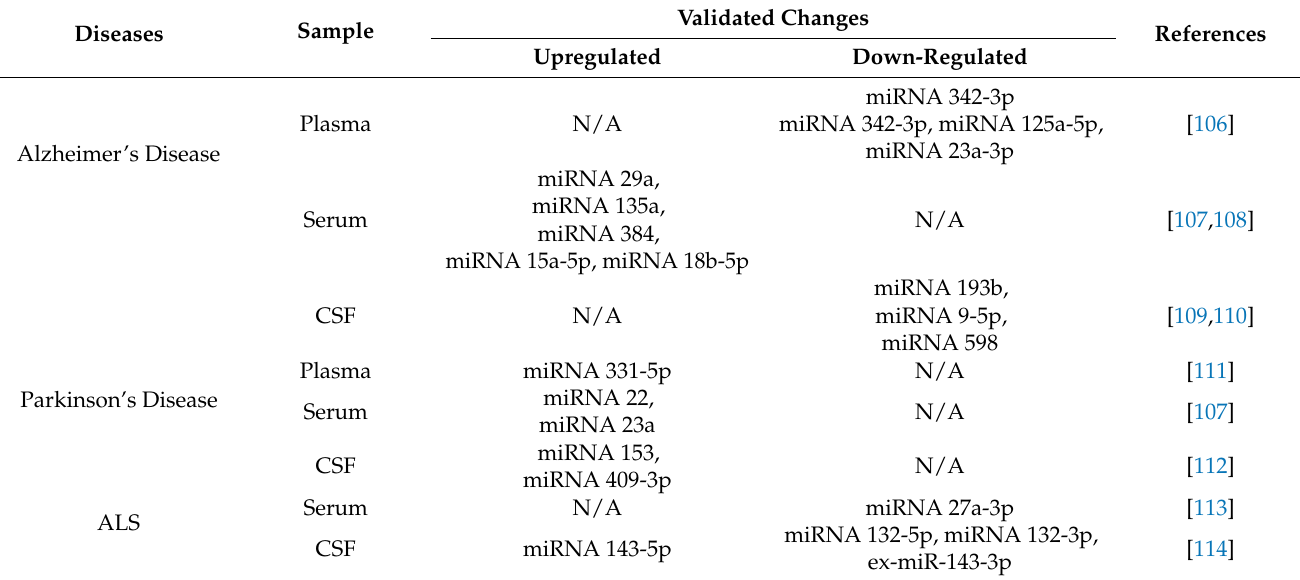
Table 2. Levels of miRNAs that are upregulated or downregulated in different